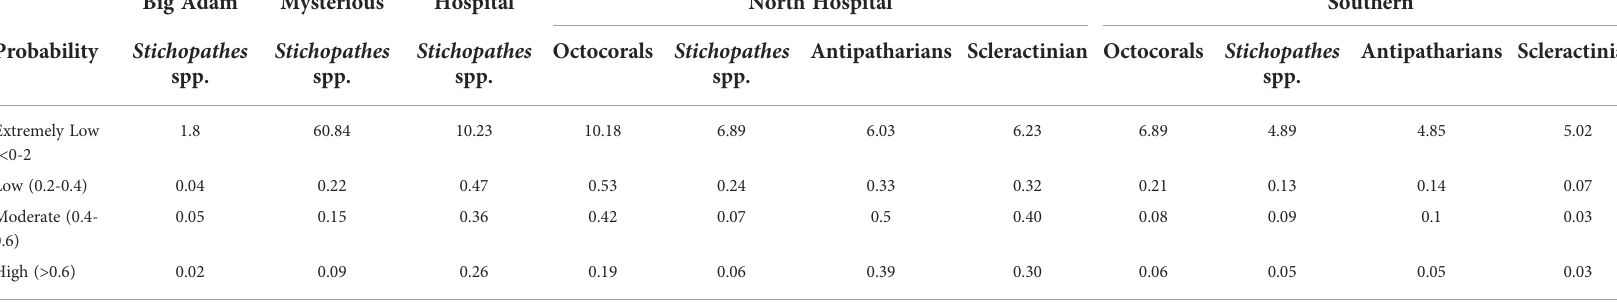
TABLE 4 MaxEnt habitat suitability predictions (km 2 ) for each bank and species